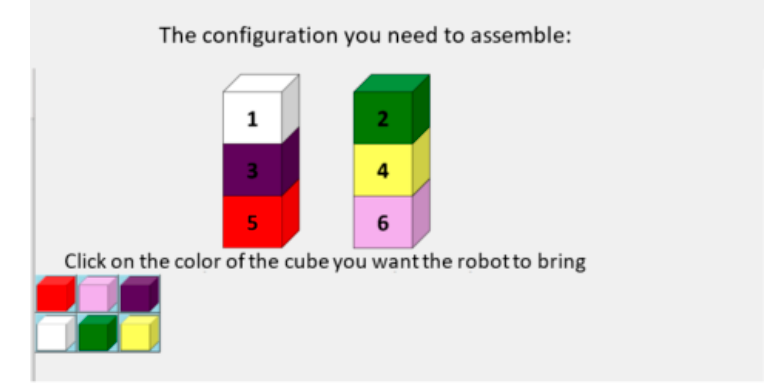
Figure 2. The GUI screen.